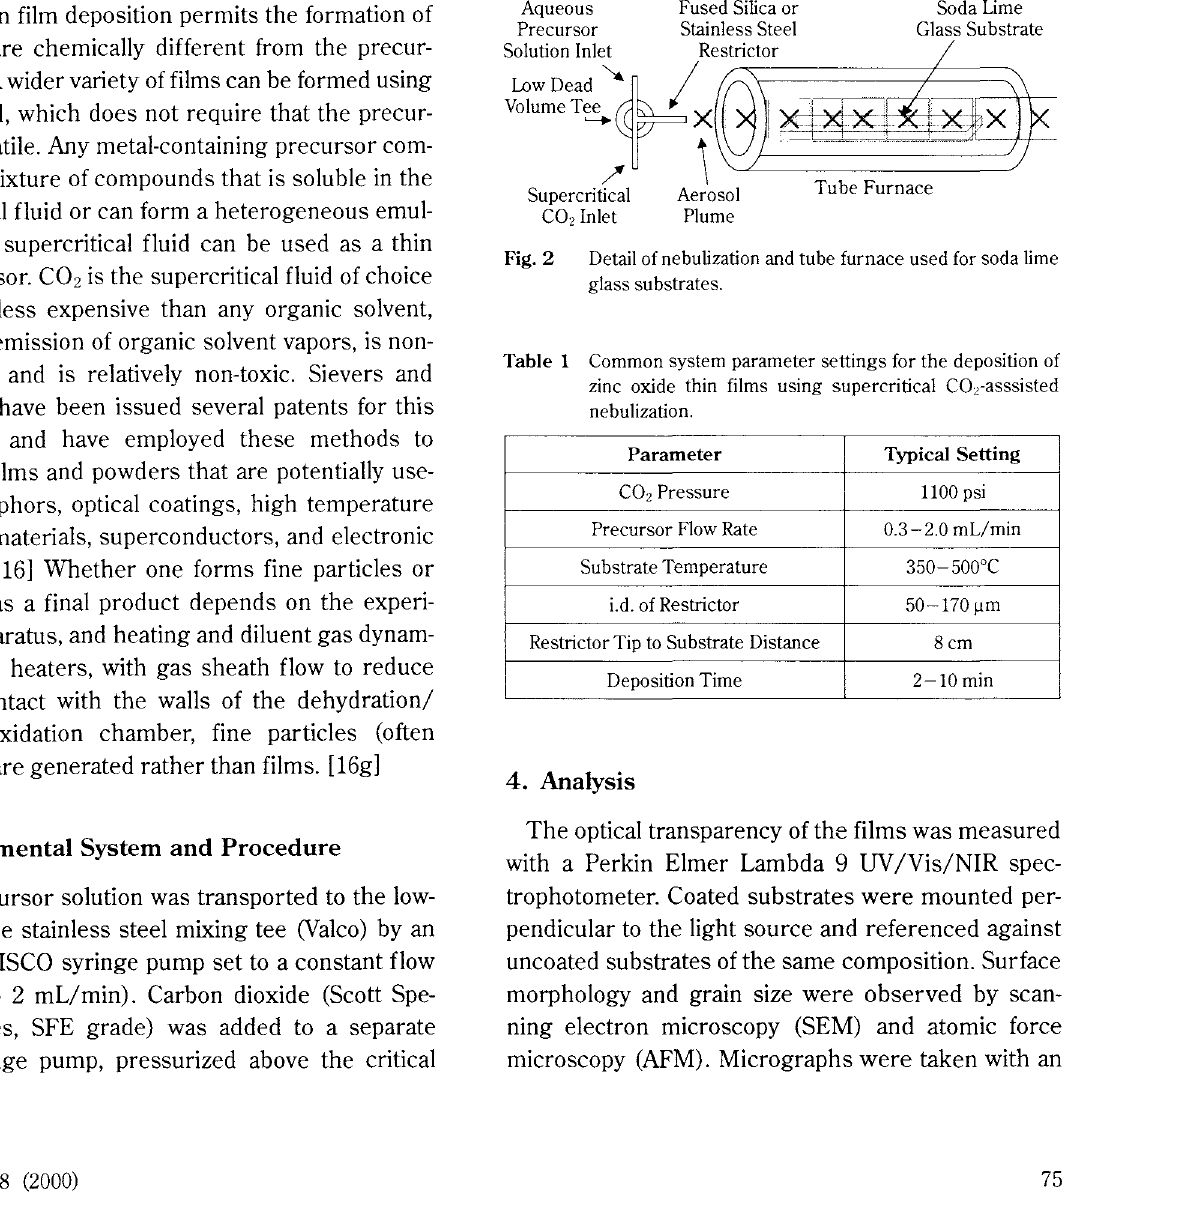
Detail of nebulization and tube furnace used for soda lime glass substrates.